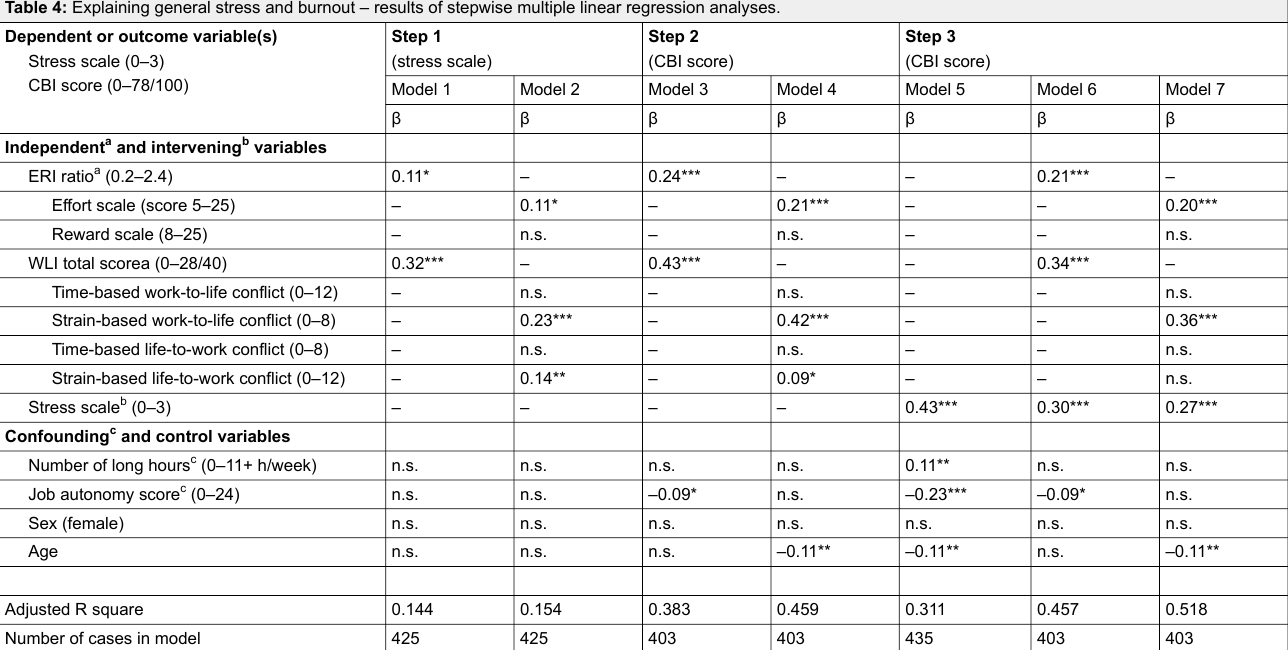
Table 4: Explaining general stress and burnout – results of stepwise multiple linear regression